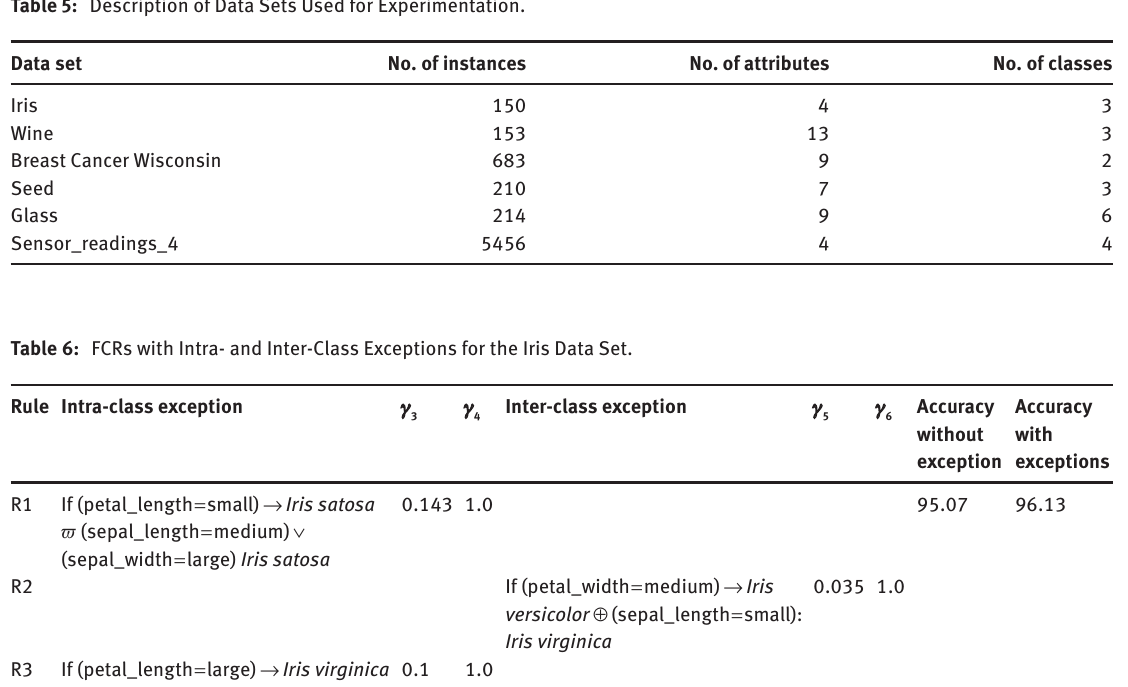
Table 5: Description of Data Sets Used for Experimentation.